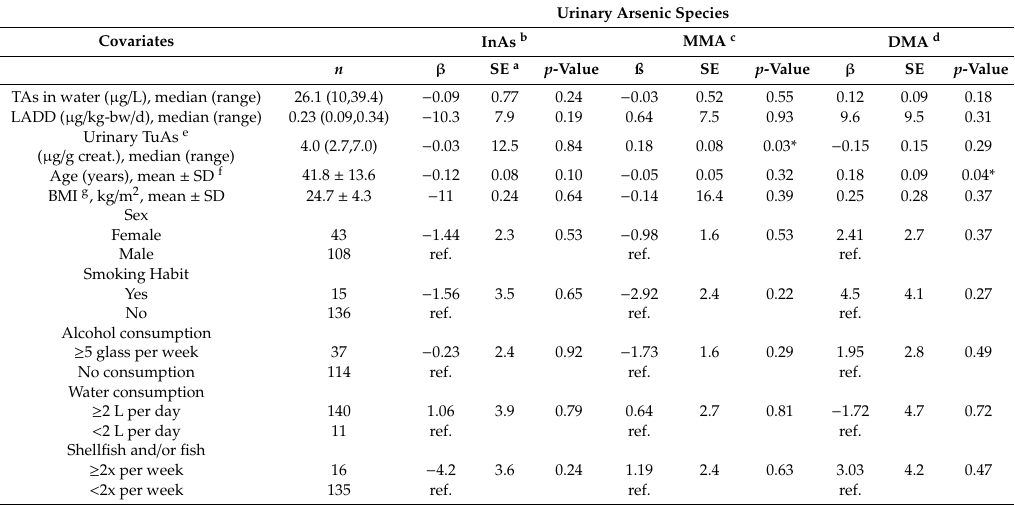
Table 2. Univariate analyses of polymorphic variants GST and As3MT on urinary arsenic metabolites. Urinary Arsenic Species Genotypes InAs b MMA c DMA d n β SE a p -Value SE p -Value GSTT1 Null ref. ref. ref. ref. ref. GSTP1 (rs1695) AG + GG ref. ref. ref. GSTO2 (rs156697) 0.001 * TT (wild-type) 102 ref. ref. ref. As3MT(rs374040) TG + GG 89 0.15 < 0.001 * < 0.001 *